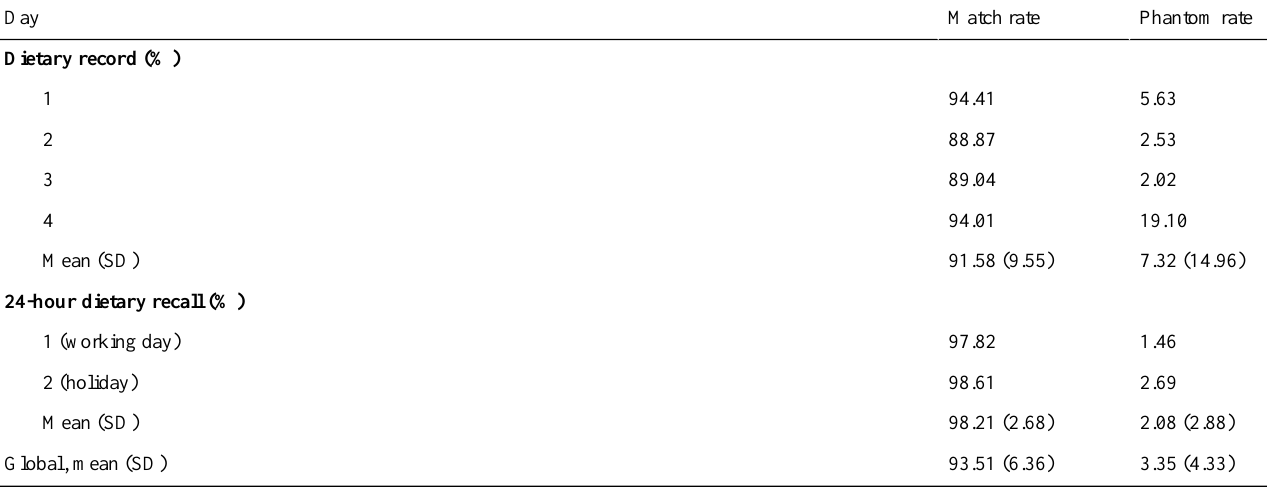
Table 3. Agreement between the Energy Balance on Cancer (BENECA) mHealth system and each gold standard assessment method.